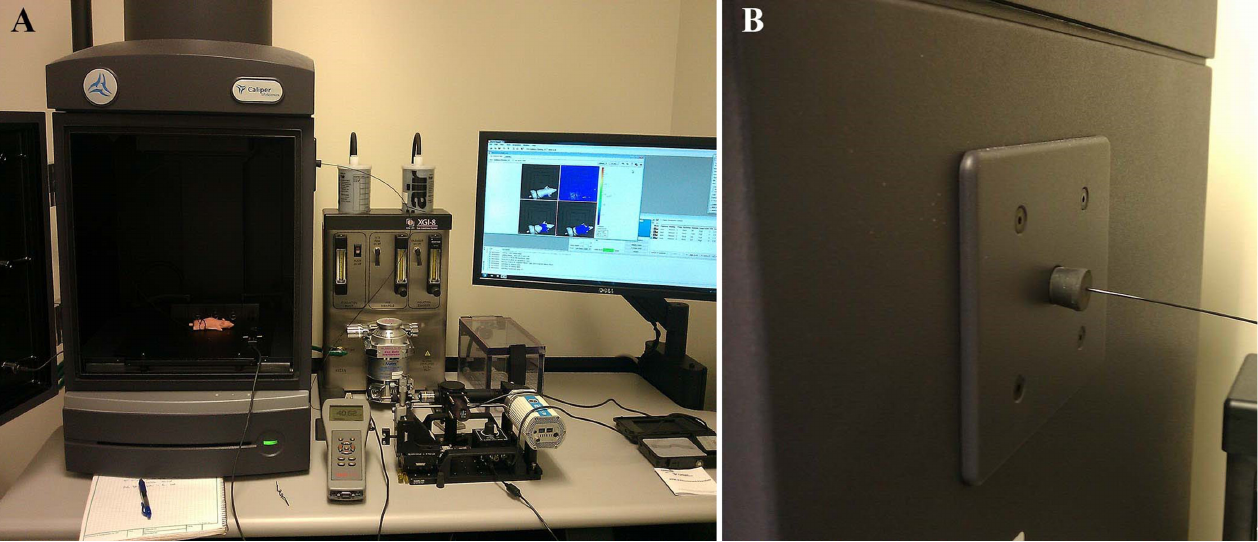
Fig 2. Integrated fluorescence imaging system. (A) Integration of the intravital fiber excitation source into the IVIS whole-animal imaging system. (B) The fiber is coupled via a test tube stopper placed into the access port of the IVIS system. doi:10.1371/journal.pone.0149932.g002 PLOS ONE | DOI:10.1371/journal.pone.0149932 February 22,